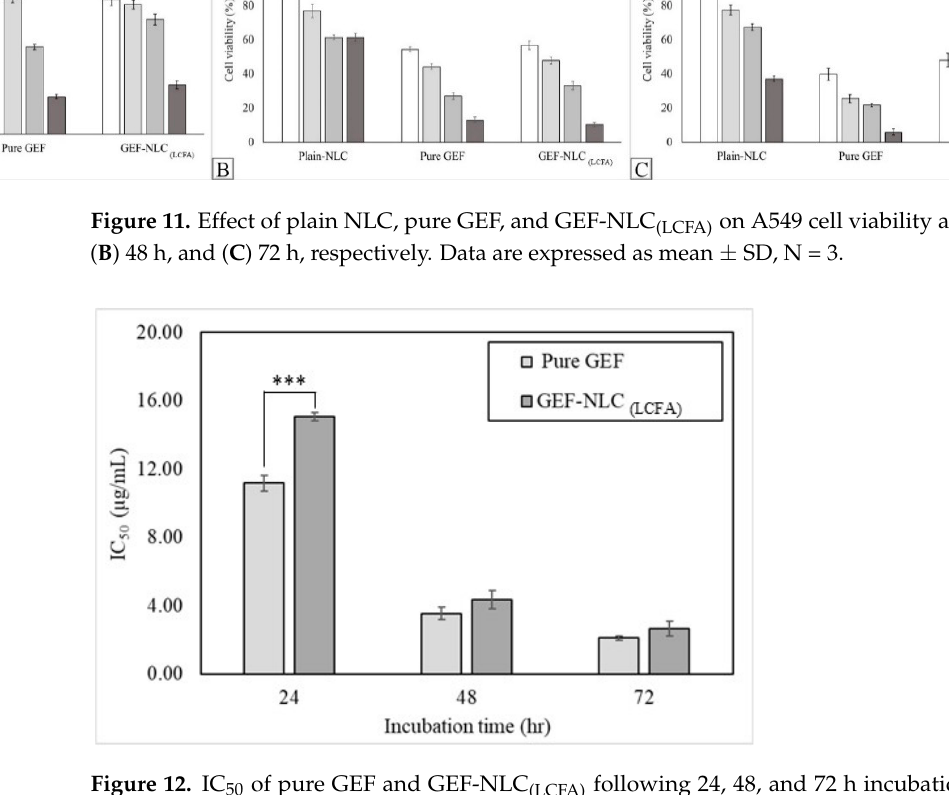
Figure 12. IC 50 of pure GEF and GEF-NLC (LCFA) following 24, 48, and 72 h incubation. Data are ex- pressed as mean ± SD, N = 3, p -value significant at *** 0.001.